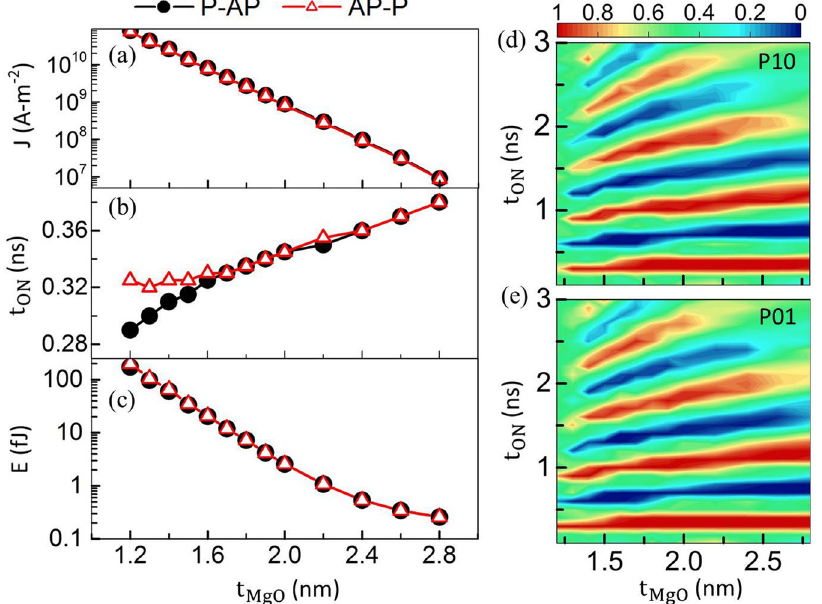
Figure 4. Effects of t MgO on ( a ) current density, ( b ) t ON (optimal values used to switch, i.e. t Half ) and ( c ) energy consumption per switching operation at 1.6 V V 0 and 50 mT μ 0 H x . Red lines with open triangles show the process from AP-to-P. Black lines with solid circles correspond to the process from P-to-AP. The smallest switching energy achieved is 0.3 fJ. Phase diagram for switching probability from ( d ) P-to-AP and ( e ) AP-to-P vs . t ON and t MgO